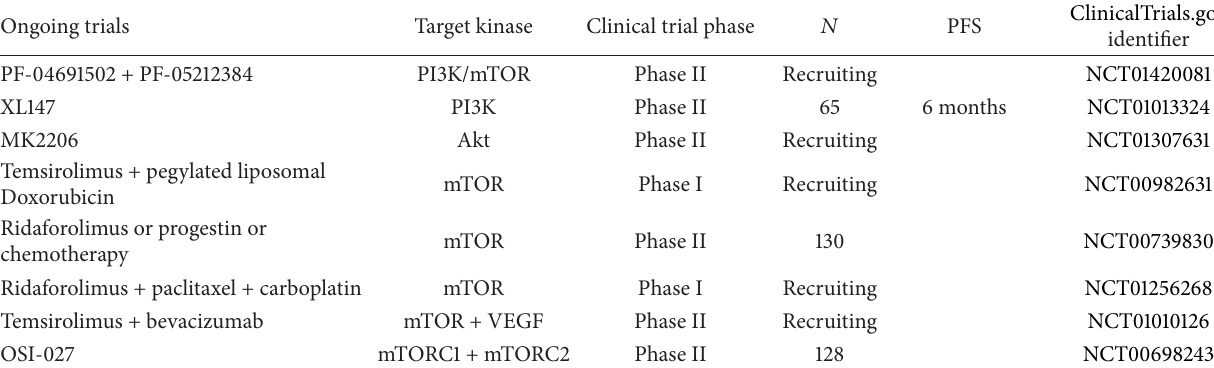
Table 2: PI3K/Akt/mTOR inhibitors in ongoing